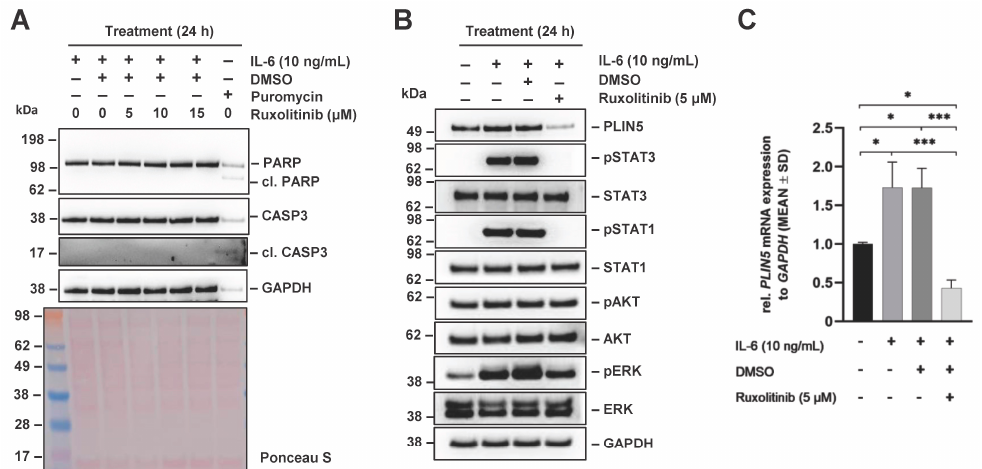
Figure 5. Effects of JAK inhibitor Ruxolitinib on IL-6-mediated PLIN5 upregulation in Hep3B cells. Hep3B cells were pretreated with the JAK inhibitor Ruxolitinib (5 µM) for 1 h and subsequently incubated with IL-6 (10 ng/mL) for 24 h. ( A ) None of the Ruxolitinib concentrations used induced apoptosis as demonstrated by the lack of elevated cleaved PARP or CASP3 quantities when compared with the apoptosis inducing control Puromycin (5 µg/mL). ( B ) PLIN5 expression and STAT3 phosphorylation, a downstream target of JAK, were analyzed by Western blot, demonstrating that Ruxolitinib blocked IL-6-induced PLIN5 protein expression. ( C ) Effect of Ruxolitinib and IL-6 treatment was assessed on PLIN5 mRNA expression by RT-qPCR. GAPDH expression and Ponceau S staining served as controls to demonstrate equal protein loading. Significant differences between the groups are marked by asterisks (* p < 0.05, *** p < 0.001).